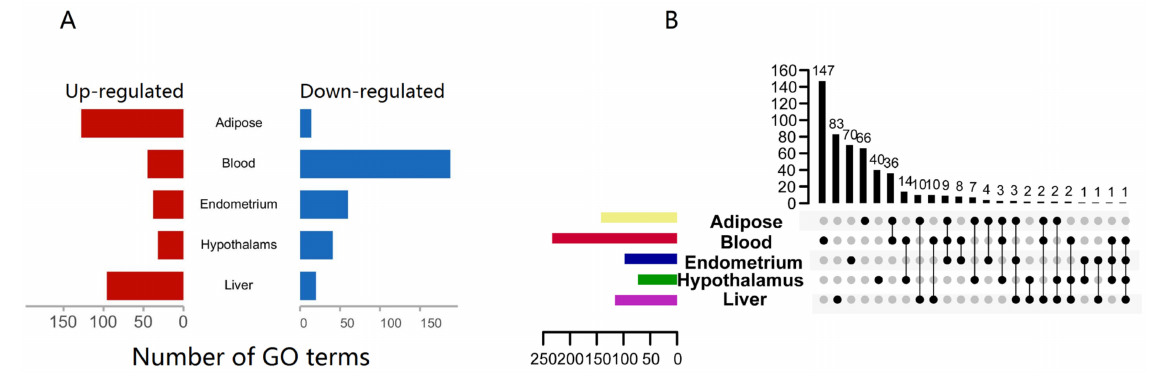
Figure 2. GSEA of innate immune genes from different tissues. ( A ) Number of GO(BP) terms enriched by GSEA ( p -value < 0.05); ( B ) upset plot of the GO(BP) terms enriched by GSEA ( p -value < 0.05), both the x-axis and y-axis for the numbers of terms.